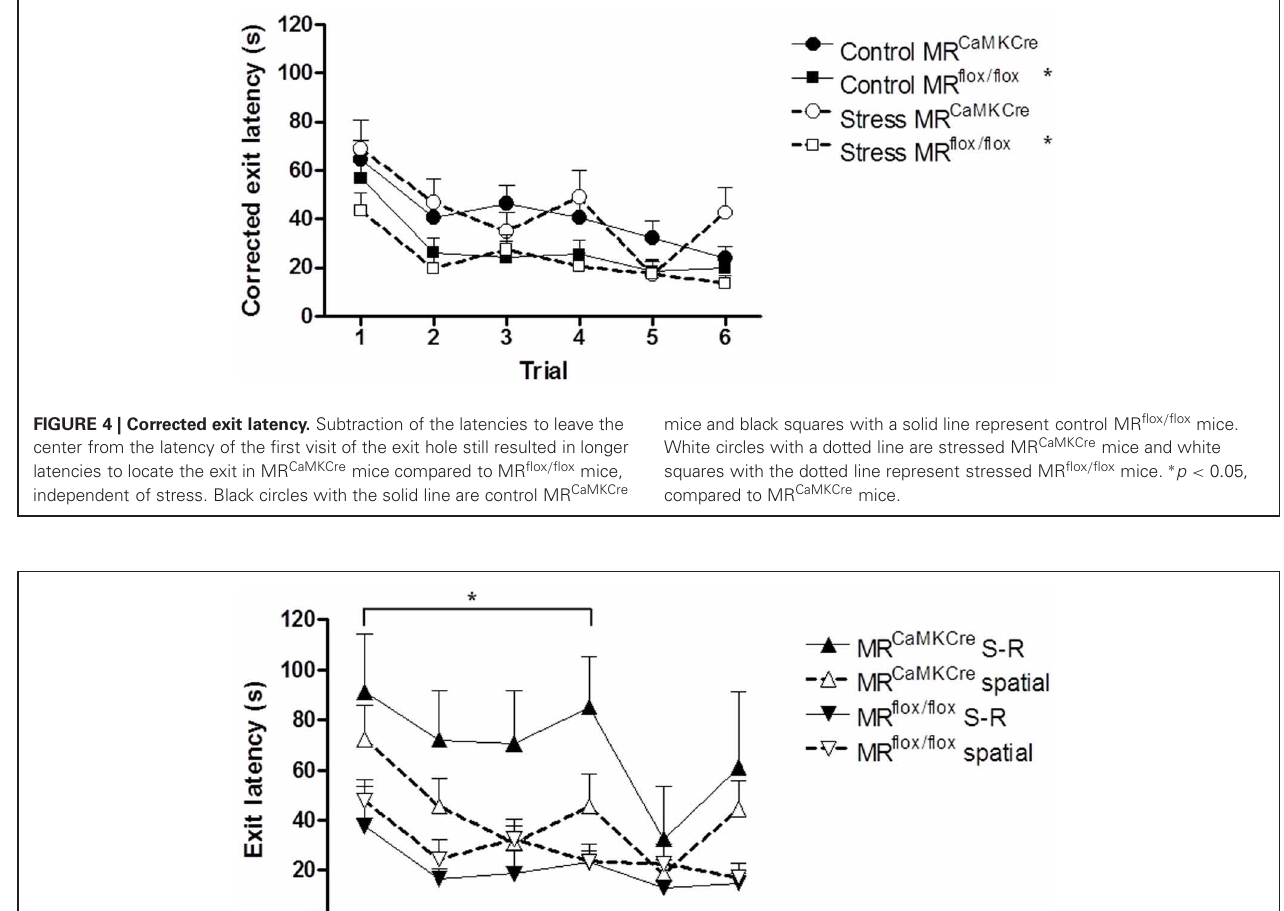
FIGURE 5 | Exit latency of stressed mice grouped according to the strategy revealed by the test trial. Stressed MR CaMKCre mice using the stimulus-response strategy ( n = 4) need more time to find the exit hole compared to MR CaMKCre mice using the spatial strategy ( n = 14). Strategy (stimulus-response n = 4, spatial n = 17) did not affect the performance of